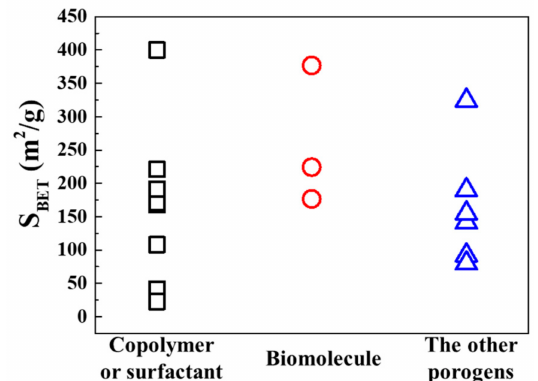
Figure 8. The reported S BET value of porous MMO prepared by the porogen-LDH. Porogen: micelle forming copolymer or surfactants (open square), biomolecules (open circle), the other porogens (open